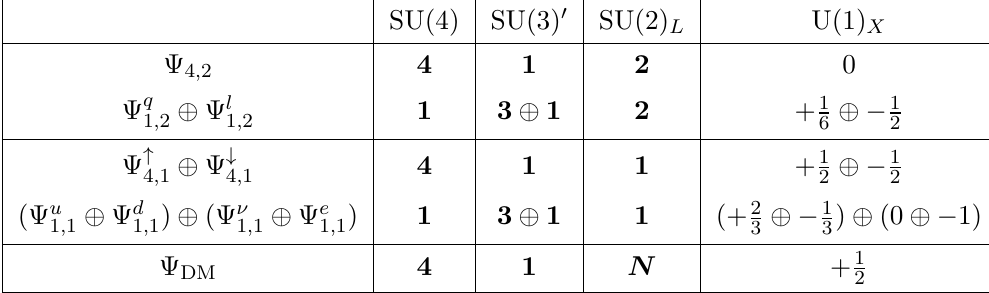
Table 3 . Quantum numbers of fermions in the model. Fields with the same quantum numbers as the SM fermions are denoted by (cid:9) IJ , where I 2 f 4 ; 1 g and J 2 f 2 ; 1 g are the dimensions of the SU(4) and SU(2) L representations, respectively. (cid:9) DM is the multiplet containing (cid:31) and